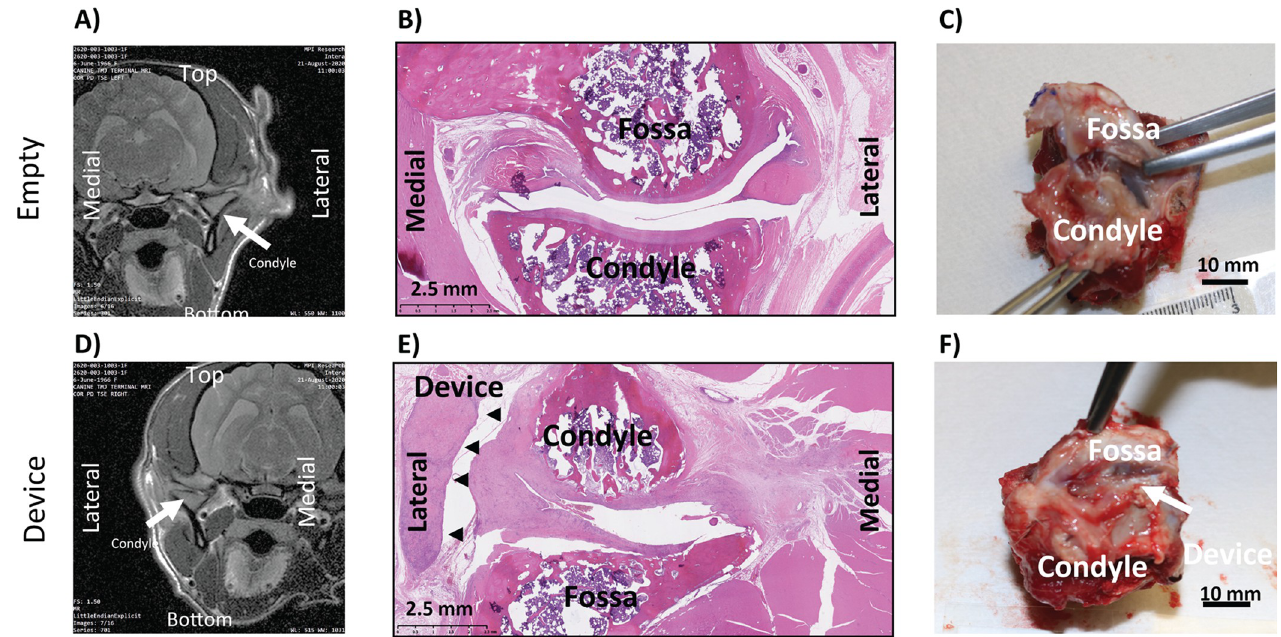
Fig 4. Animal 1003: Coronal MRI of empty (A) and implanted (D), Sagittal H&E of empty (B) and implanted (E), Necropsy Picture of empty (C) and implanted (F).